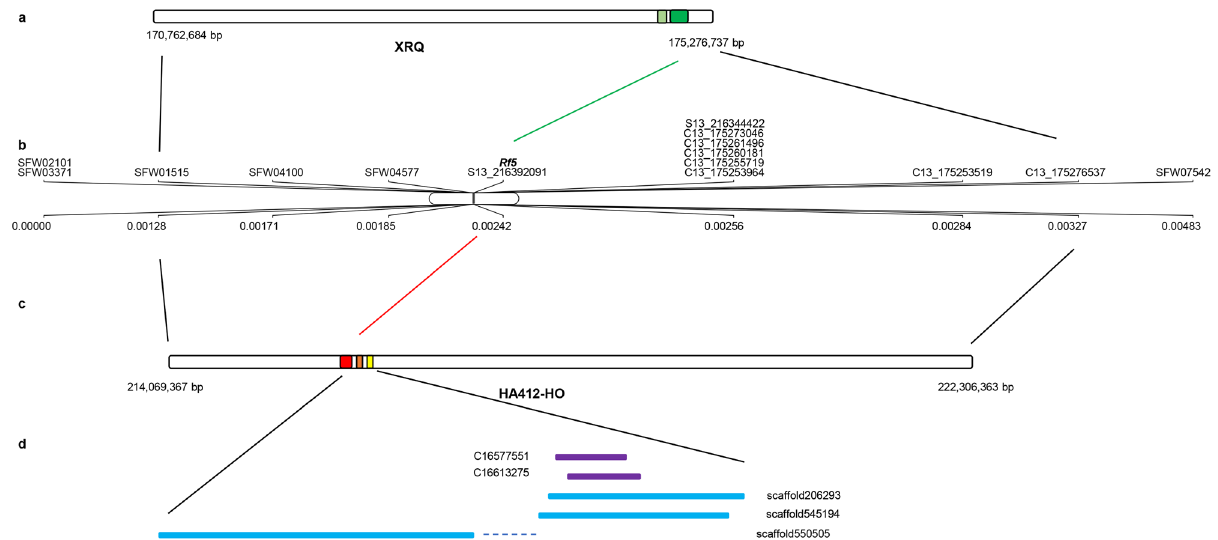
Figure 2. Illustration of Rf5 gene along sunflower chromosome 13. ( a ) Extracted XRQ genomic region covering Rf5 . Light and dark green bars highlight candidate Rf5 genes HanXRQChr13g0420361 and HanXRQChr13g0420371; ( b ) Fine map of Rf5 on sunflower chromosome 13 showing the relative positions of Rf5 and its linked markers; ( c ) Extracted HA412-HO genomic region covering Rf5 . Red, orange and yellow bars highlight candidate Rf5 genes Ha412v1r1_13g048240, Ha412v1r1_13g048250 and Ha412v1r1_13g048260; ( d ) Solid purple and blue bars show the relative positions of HA-R9 contigs and scaffolds, respectively, aligned to the Rf5 targeted region of the HA412-HO reference genome, and the dotted line represents the gap. Candidate gene Contig and scaffold % identity Alignment length (bp) E-valueQuery id Length (bp) Subject id Length (bp)